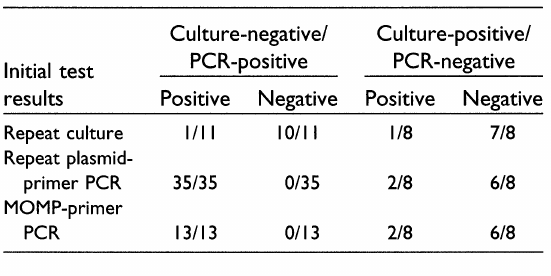
TABLE 5. Performance of culture and PCR-based testing compared to true results determined